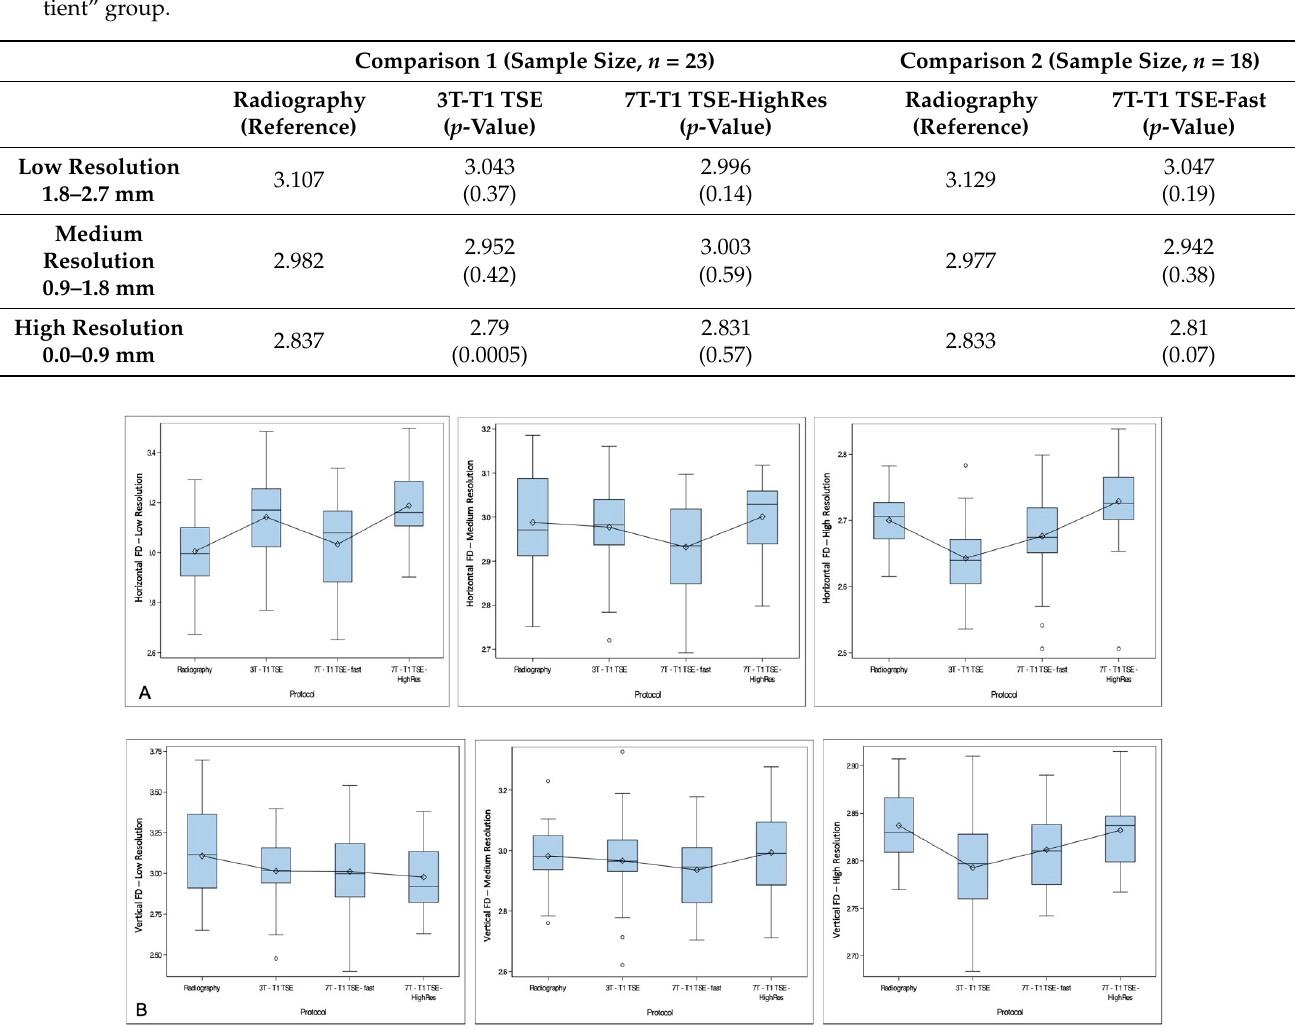
Table 5. Comparison of vertical fractal dimensions between radiography and different MRI T1 sequences in the “patient” group. Comparison 1 (Sample Size, n = 23)